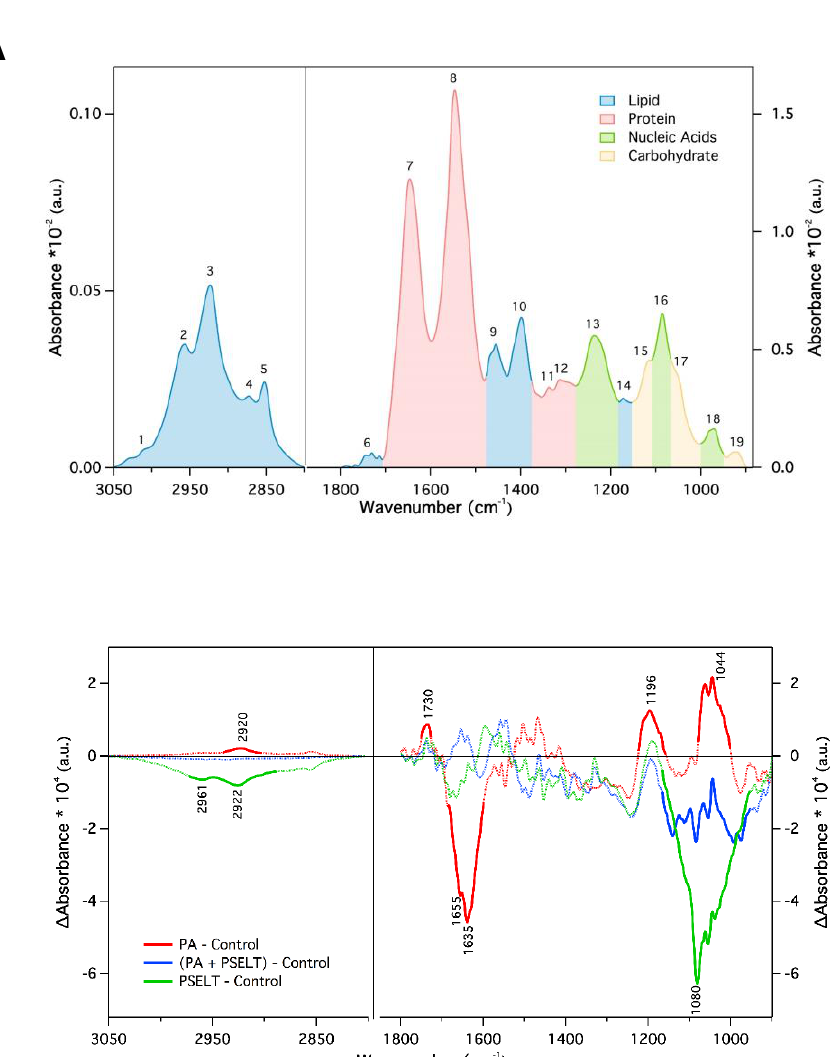
Figure 7. Effects of PSELT on FTIR spectral-related macromolecular changes of PA-treated H9c2 cardiomyocytes. ( A ) Representative mean ATR-FTIR spectrum of untreated H9c2 cells recorded at 37 °C in solution. The lipid region (3050–2800 cm −1 ) and the fingerprint region (1800–900 cm −1 ) are shown with the absorption of the different biomolecules. The labelled peaks indicate the absorbance of specific functional groups ( B ) Infrared difference spectra between differently treated cells H9c2 minus the mean spectrum obtained for untreated control H9c2 cells. Pre-processing spectral analysis included baseline correction and normalization to the area under the amide II band. The statistical significance (α = 0.01) was determined by using Student’s t -test at each wavenumber, and the spectral regions with p -values < 0.0001 are shown as thicker colored lines. (a.u. indicated arbitrary units). Table 1. Band Assignments of the Main Peak Absorption of Cells in the 3050–900 cm −1 IR Spectral Region [34,35].